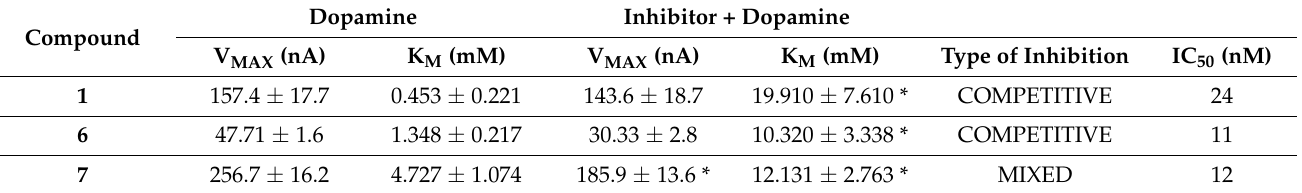
Table 1. V MAX (expressed in nA) and K M (expressed as mM concentrations) obtained from biosensors’ calibrations, in absence or not of the inhibitor. For each inhibitor was built a group of biosensors (n = 4) and parameters’ variations were listed. Statistical significance (* p < 0.05 vs. dopamine) was evaluated by means of t -test. Type of inhibition and calculated IC 50 were tabulated too. Concentrations were expressed in